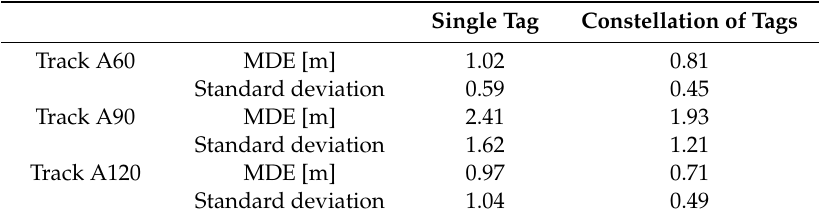
Table 4. The mean estimated distance errors by simulation.